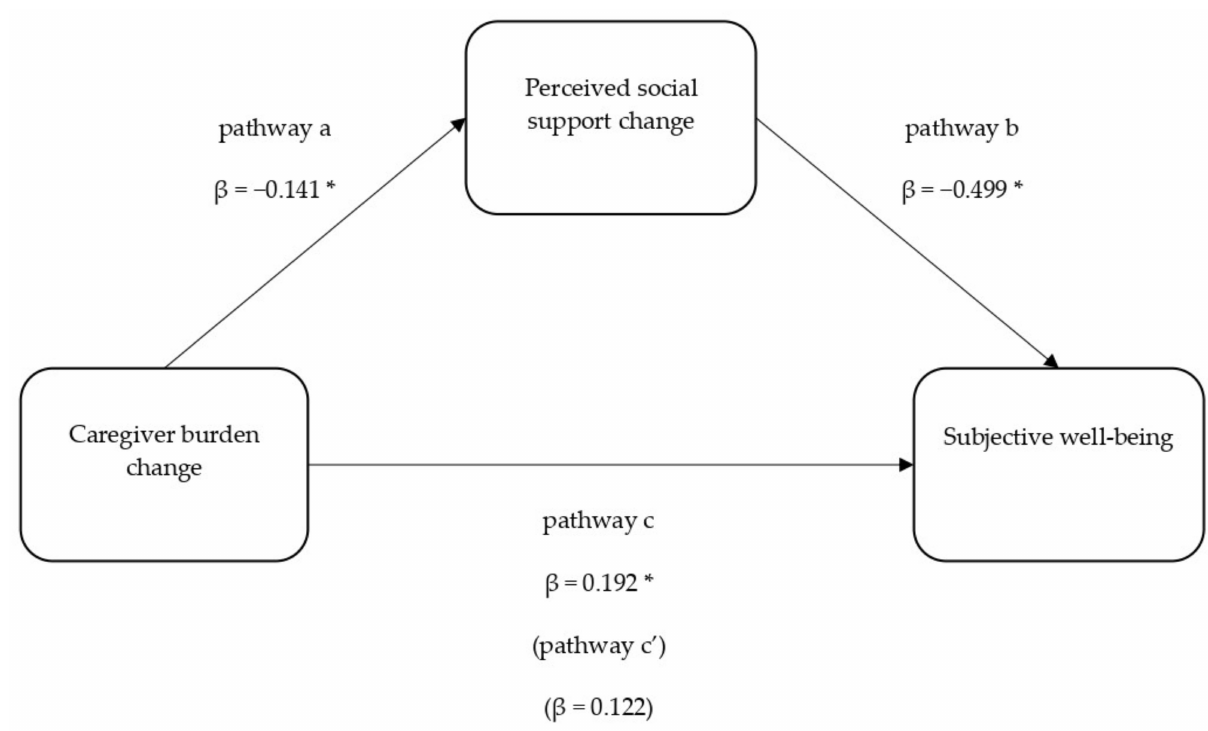
Figure 3. Mediation model of caregiver burden change and quality of life through perceived social support change. * p <